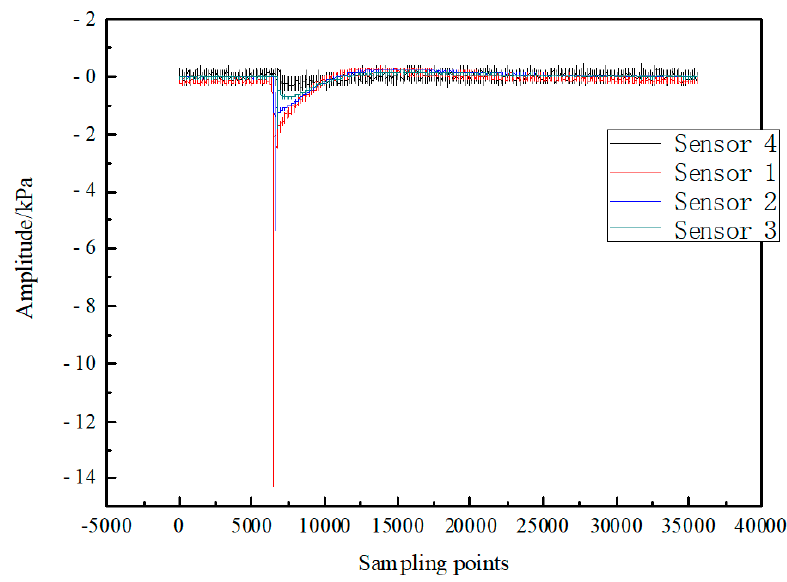
Figure 10. The acoustic signals measured by the sensors in the same direction. Table 5. The fitted ACs when acoustic waves propagate downstream.